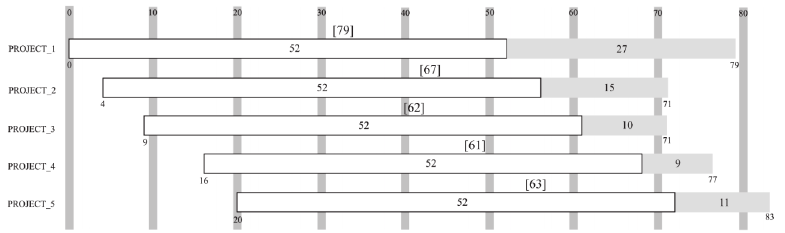
Fig. 5. Schedule provided by the algorithm proposed by Villafáñez et al. (2019) in which prioriti- zation is not